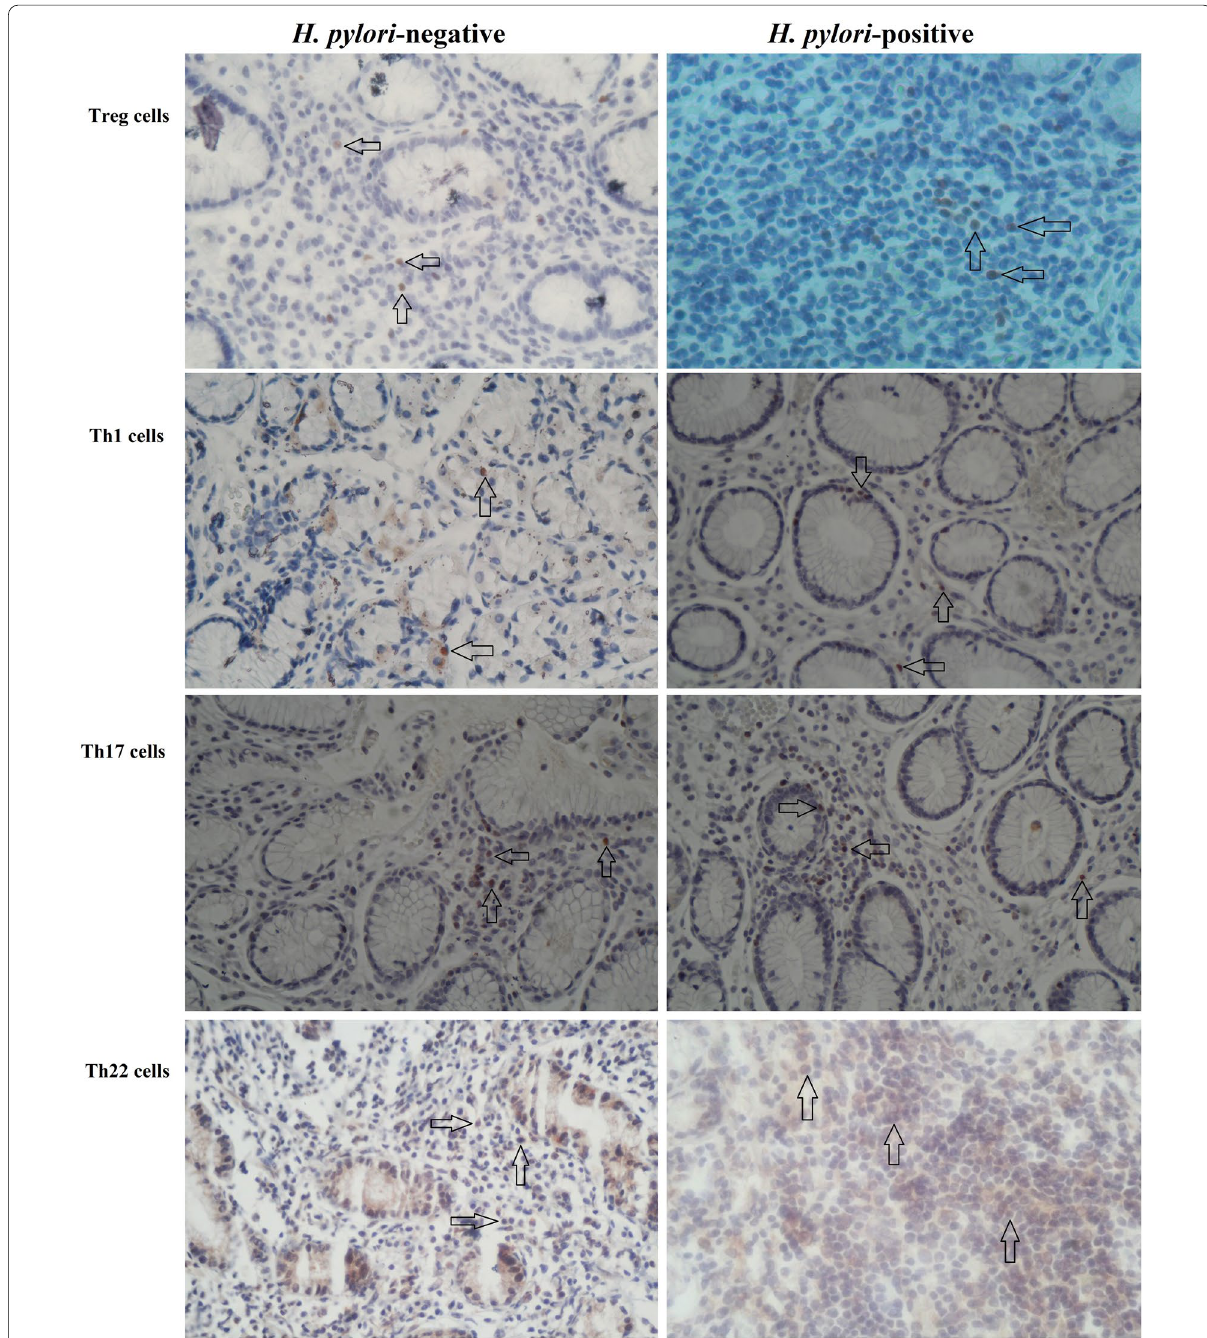
Fig. 7 Immunohistochemistry of Treg, Th1, Th17, and Th22 cells in H. pylori ‑negative subjects and H. pylori ‑positive subjects (original magnification, 400 ). Immunohistochemistry of Tregs (row 1), Th1 (row 2), Th17 (row 3), and Th22 (row 4) in gastric mucosa from column 1) H. pylori ‑negative × subjects and column 2) H. pylori ‑positive subjects. IL‑22 staining (brown) were found on the cytoplasm of T lymphocytes, and Foxp3 (Treg), T‑bet (Th1) and RORγ (Th17) staining (brown) was located in the nucleus of T lymphocytes. The arrows show the target lymphocytes in the gastric